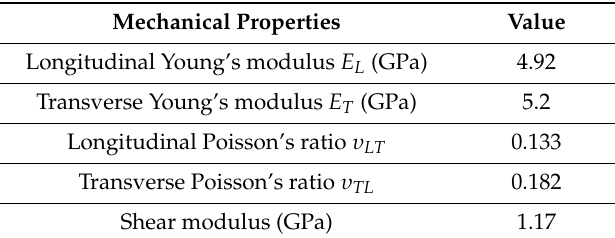
Table 1. Mechanical characteristics of laminated flax /